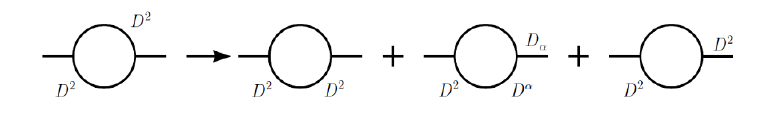
Figure 20. A one-loop diagram in Φ 3 theory.